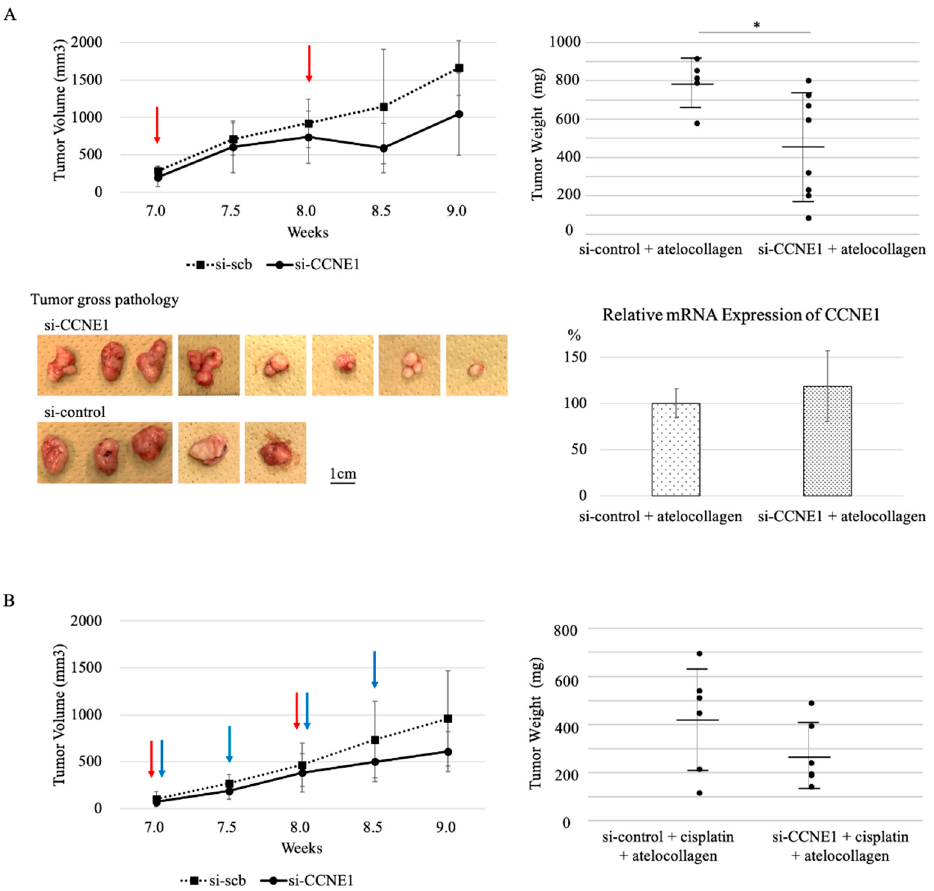
Figure 7. In-vivo efficacy of CCNE1 interference in TOV-21G xenograft mouse model. CCNE1 interference has an inhibitory effect on tumor growth. The total number in the si-control group was five, and in si-CCNE1 was eight. The tumor weight of the si-CCNE1 group (5 µ M) significantly decreased compared with that of the si-control group ( A ). However, the synergy effect of cisplatin (60 µ g/kg) ( n = 6 per group) was not observed ( B ). Red arrow indicates siRNA with atelocollagen injection, and blue arrows indicate cisplatin. * p < 0.05 vs. control.